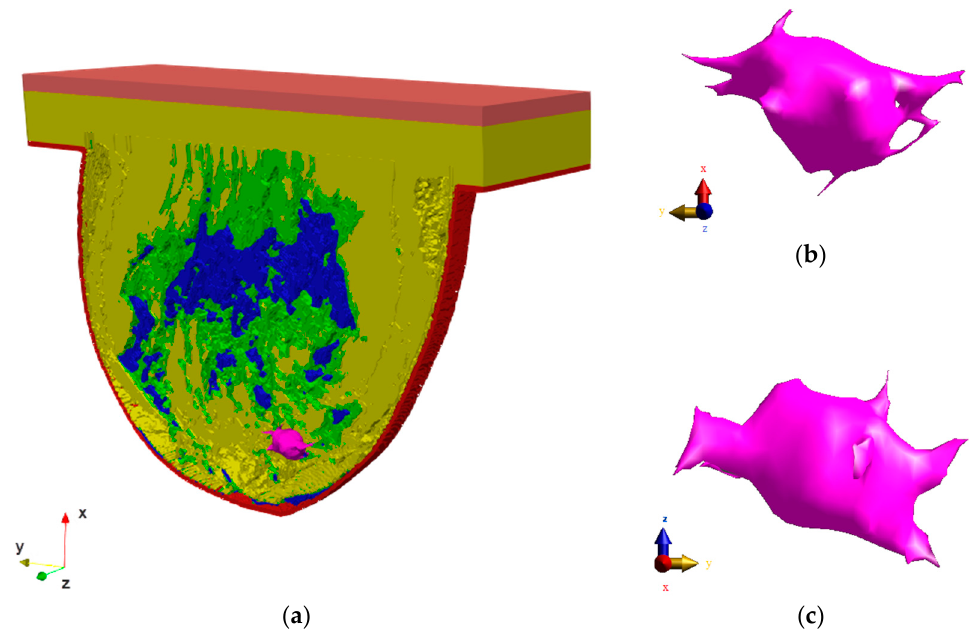
Figure 2. Views through ( a ) cross-section of the female breast phantom ( z = 0) including the main tissues: breast fat (yellow), breast gland (blue), fat (green), muscle (orange), skin (red); and ( b ) irregular breast tumor (pink) oriented in the x-y plane and ( c ) oriented in the y-z plane. The model represents a class 3 heterogeneously dense (HD) breast containing 51– 75% of fibro-connective/glandular tissue [25]. It corresponds to the breast structure of a 35-year-old female patient. In this study, the breast fat parameters were set for the fatty- 1,-2,-3 tissues, the breast gland parameters were set for the fibroconnective/glandular-1,- 2,-3 tissues, the fat tissue parameter was set for the transitional tissue, and finally the muscle tissue parameters were set for the tumor. The whole model geometry of the analyzed female breast phantom including the irregular tumor oriented in different planes is shown in Figure 2, with the muscle tissue marked in orange, the glandular tissue in blue, the fatty tissue in yellow, the transitional tissue in green, the skin tissue in red, and the tumor in pink. The tumor was immersed in fatty breast tissue. The dimensions of the modeled tumor ranged from 10.87 mm to 42.59 mm and characterized small and medium tumors in the IA, IB, and IIA stages of breast carcinoma [58]. The whole model was surrounded by the boundary condition planes with dimensions of 411 mm × 528 mm × 380 mm that represent the background (air layer), as shown in Figure 3. Figure 3. Computational area surrounding the female breast model.